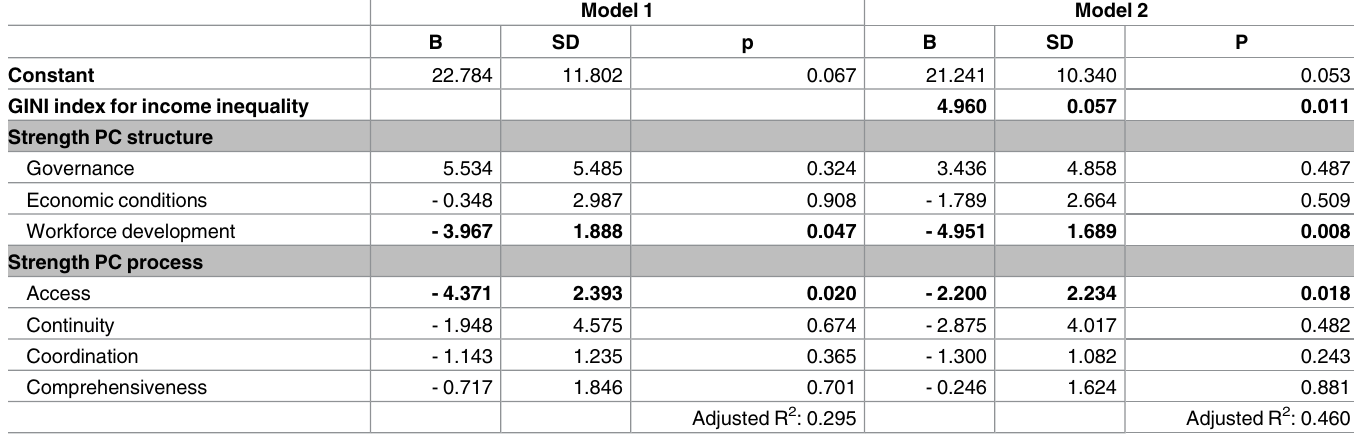
Table 4. Linear regression of the gap between low and high income groups on PC strength indicators, and in the second linear regression control- ling for the GINI index for income